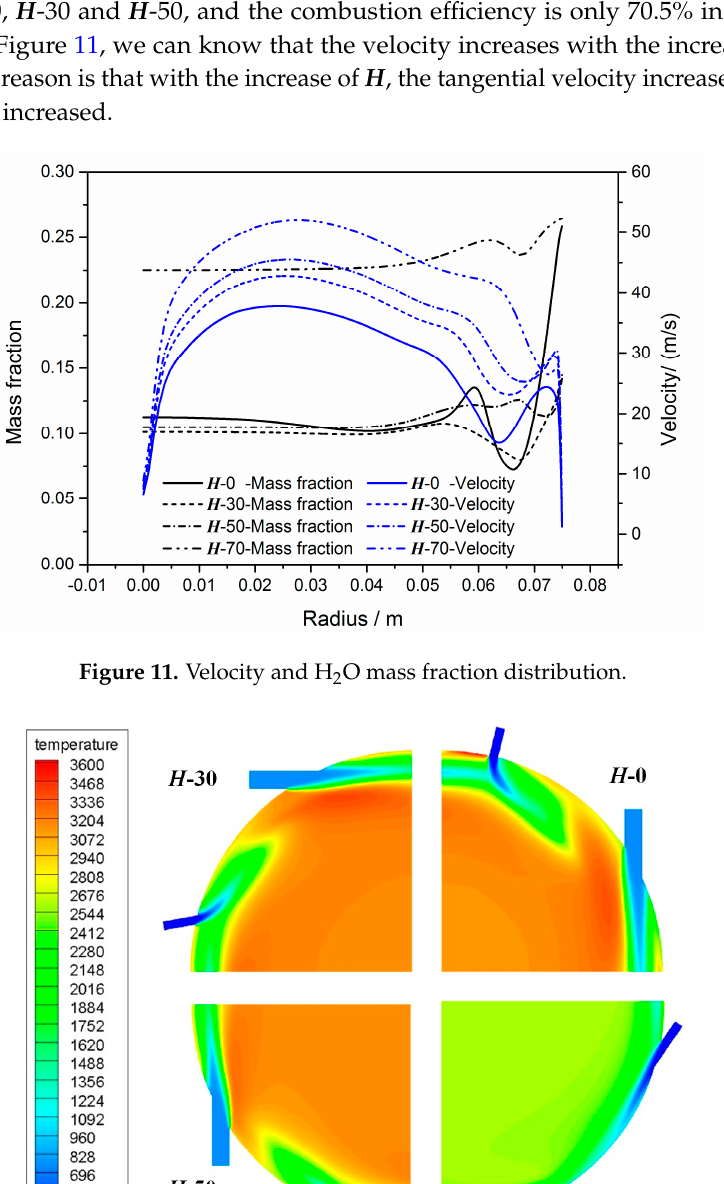
Figure 12. Temperature distribution.